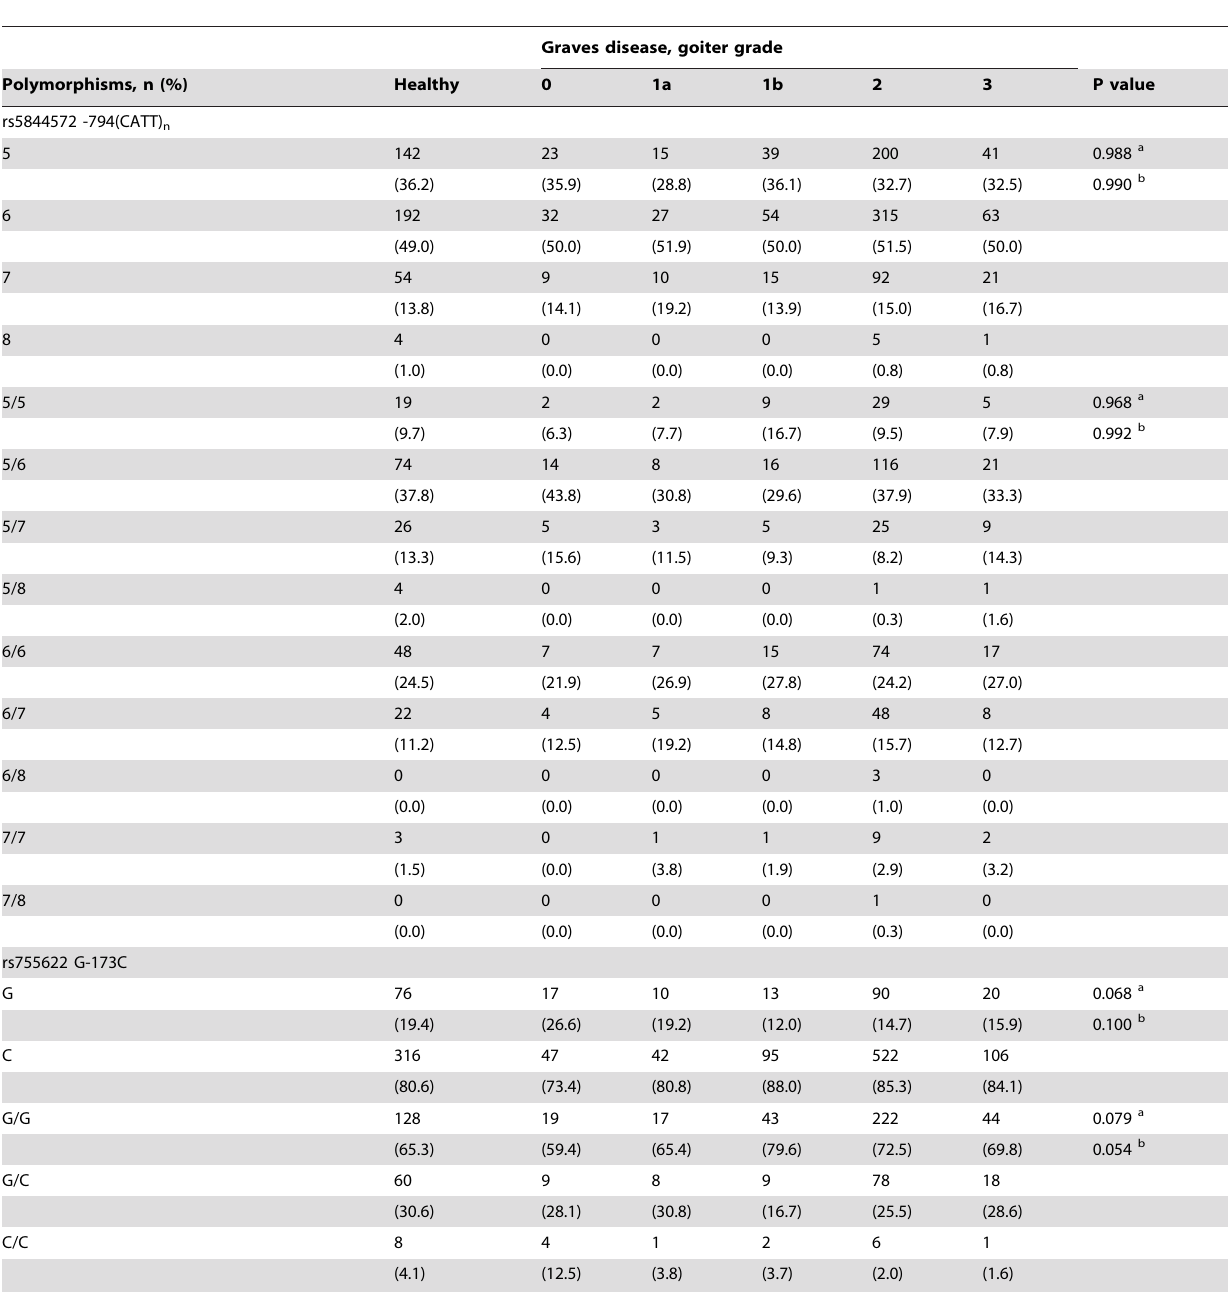
Table 2. Distributions of alleles and genotypes of the MIF polymorphisms among patients with Graves disease and healthy controls.